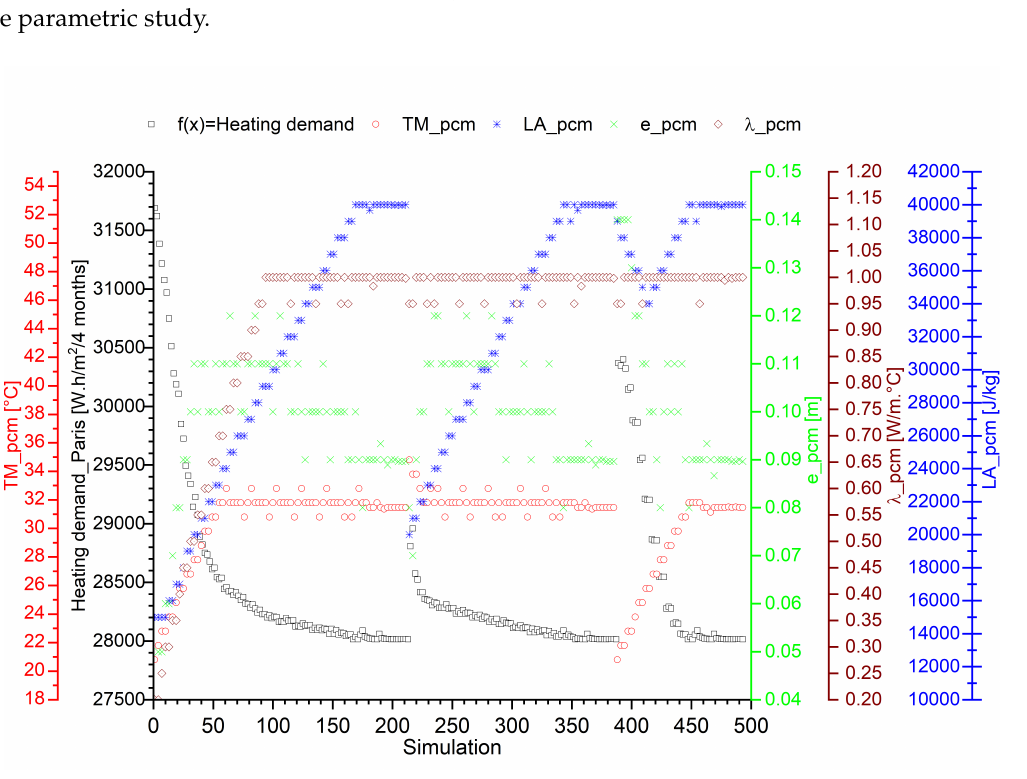
Figure 16. Variation in the objective function (f(x) = Heating demand), as subsequently simulated using three initial